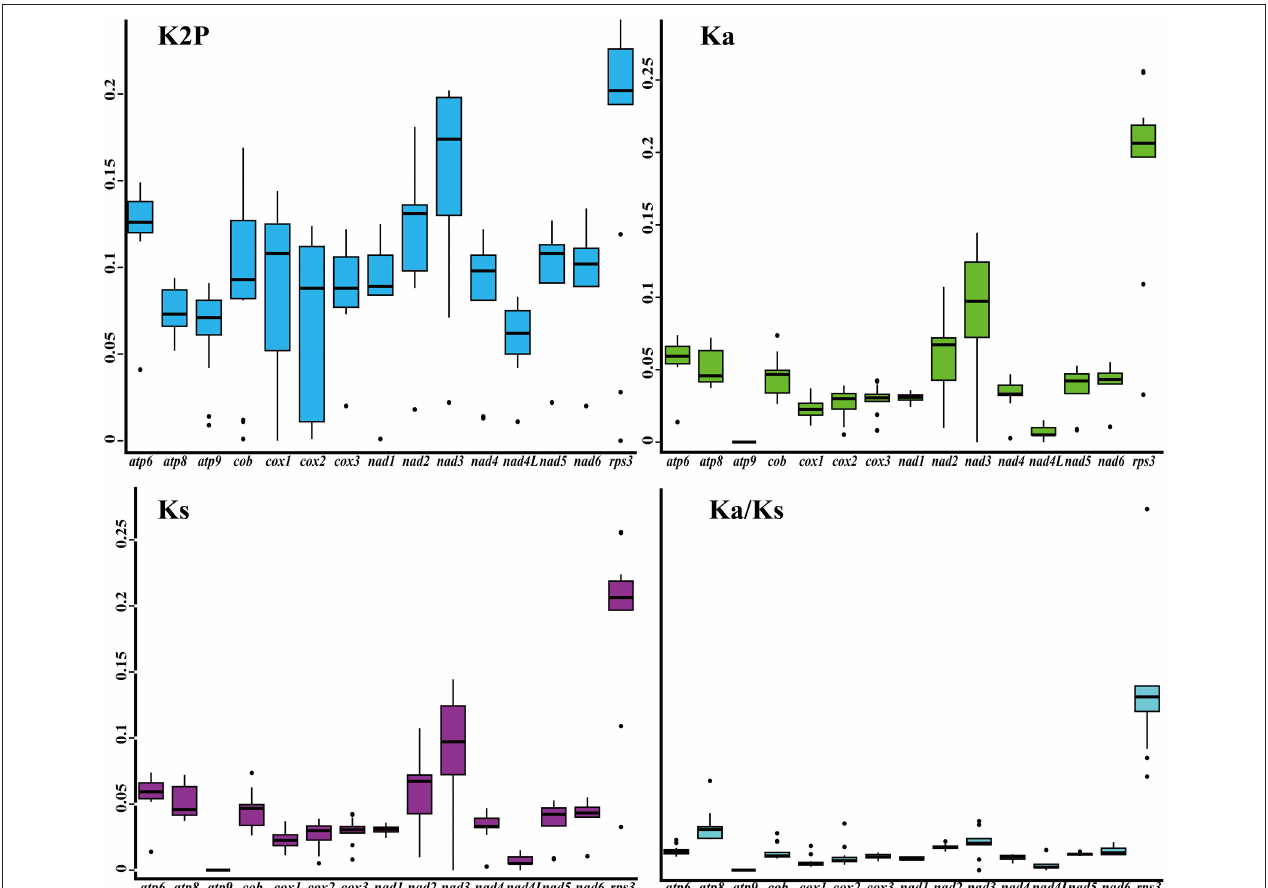
FIGURE 5 | Genetic analysis of 15 protein-coding genes conserved in the five Tricholoma mitogenomes. K2P, the Kimura-2-parameter distance; Ka, the mean number of non-synonymous substitutions per non-synonymous site; Ks, the mean number of synonymous substitutions per synonymous site.